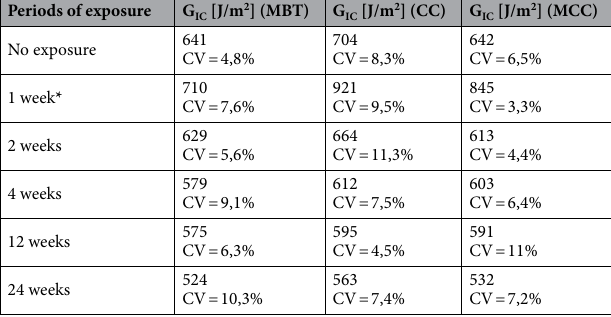
Table 2. Mode I fracture behaviour in function of exposure time in a salt spray chamber. MBT modified beam theory; CC compliance calibration method; MCC modified compliance calibration method. * Explanation for these values can be found in reference 40